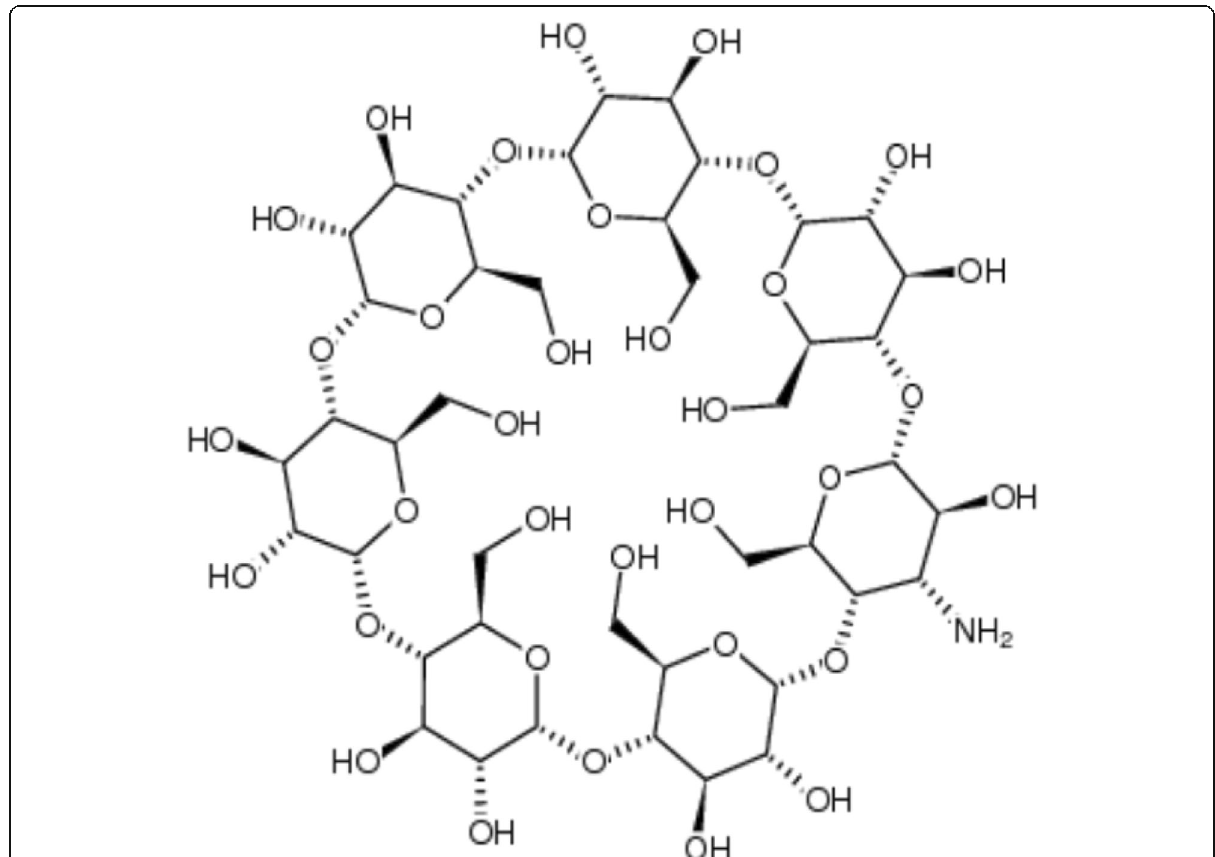
Fig. 1 The structure of 3A-amino-3A-deoxy-(2AS,3AS)- β